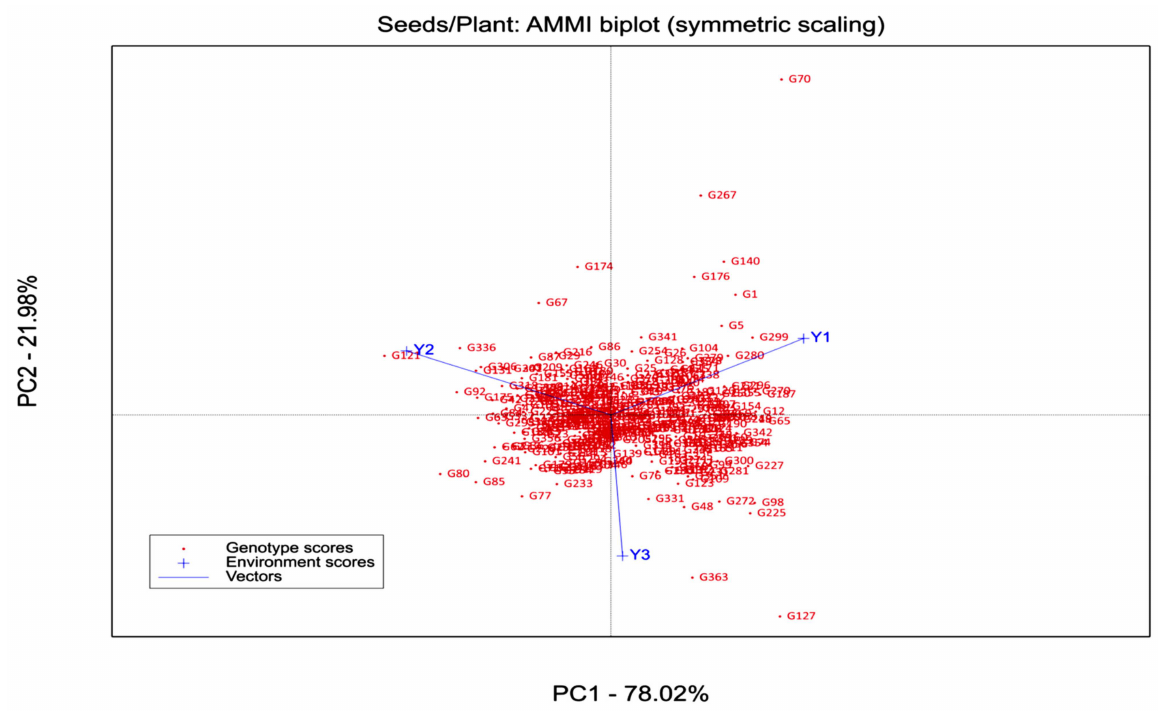
Figure 4. Seed number—AMMI2 biplot of IPCA1 vs.